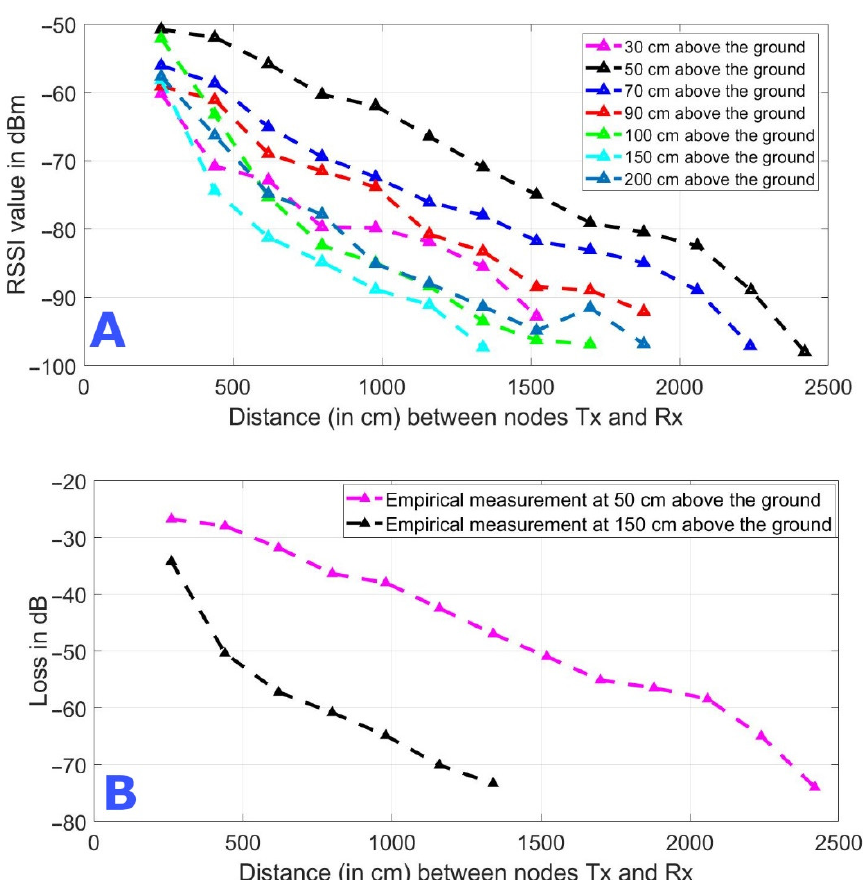
Figure 7. ( A ) Signal power levels in dBm between the transmitter (Tx) and receiver (Rx) nodes at different heights and distances between them. ( B ) Path loss or attenuation measured in dB of the radio wave between the Tx and Rx node inside the tomato greenhouse at 50 cm and 150 cm above the ground [41].